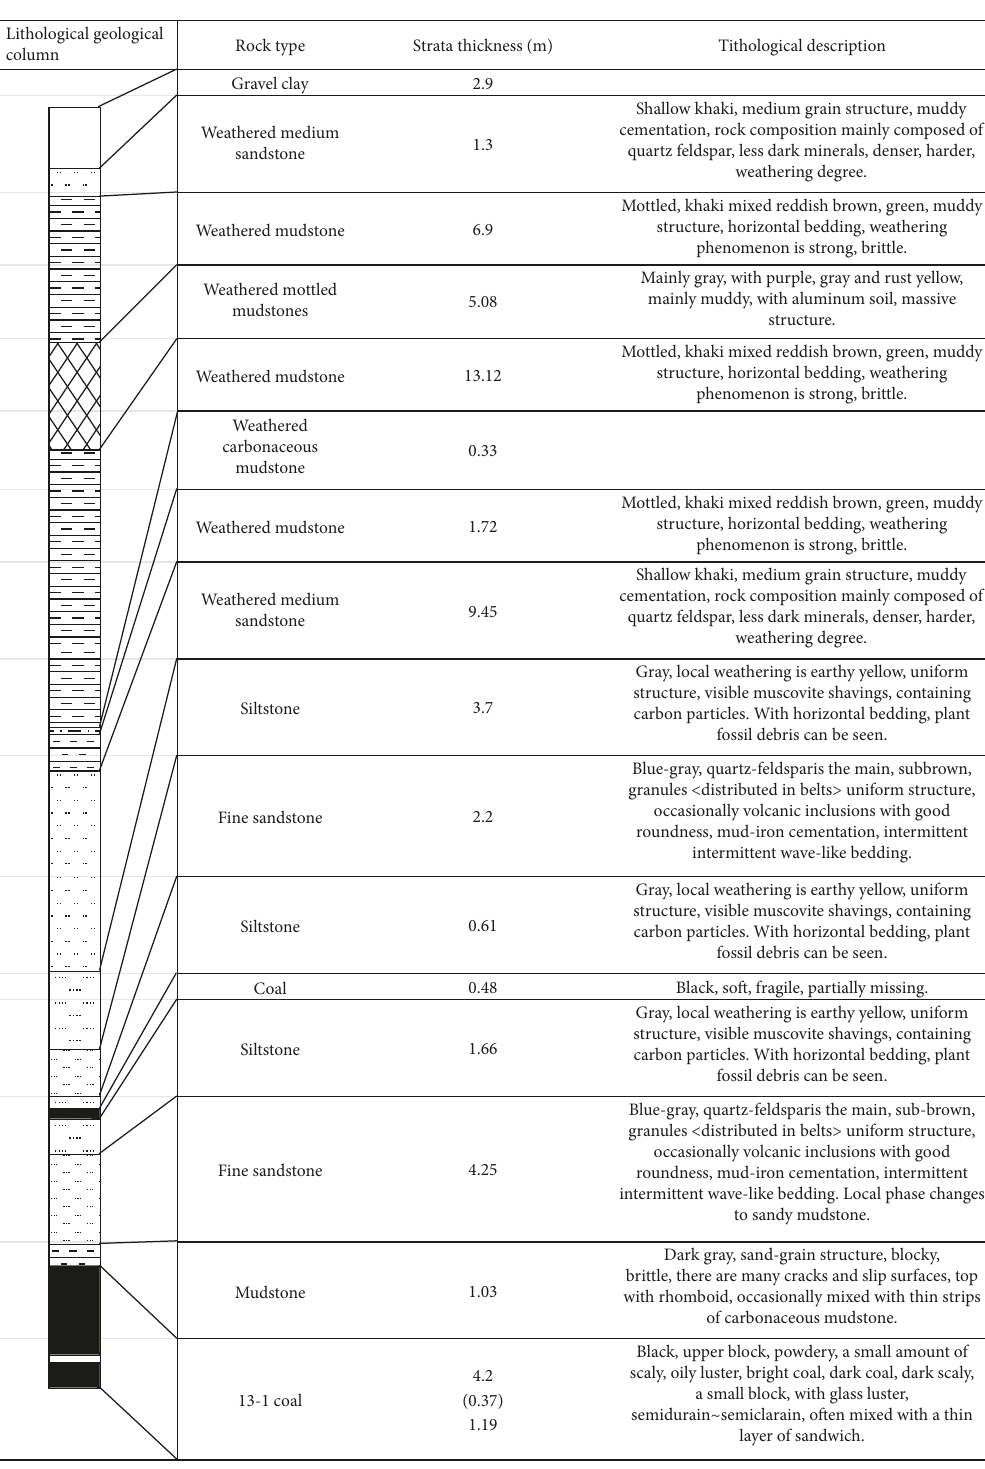
Figure 1: Drilling